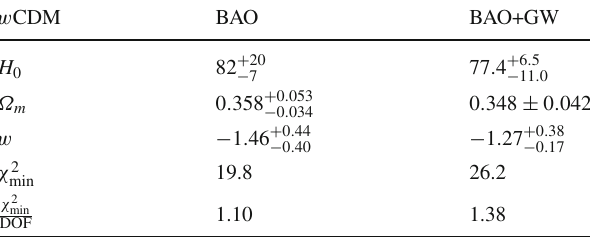
Table 3 The 68% CL constraints on the independent parameters of the w CDM model